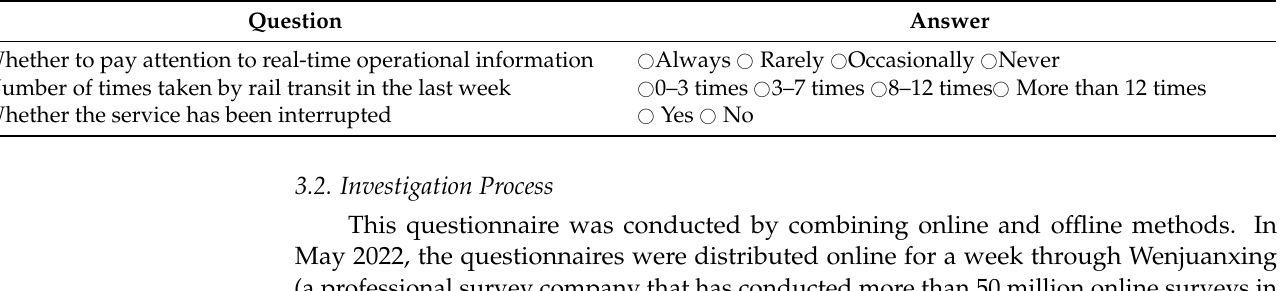
Table 5. Questionnaire design of travel